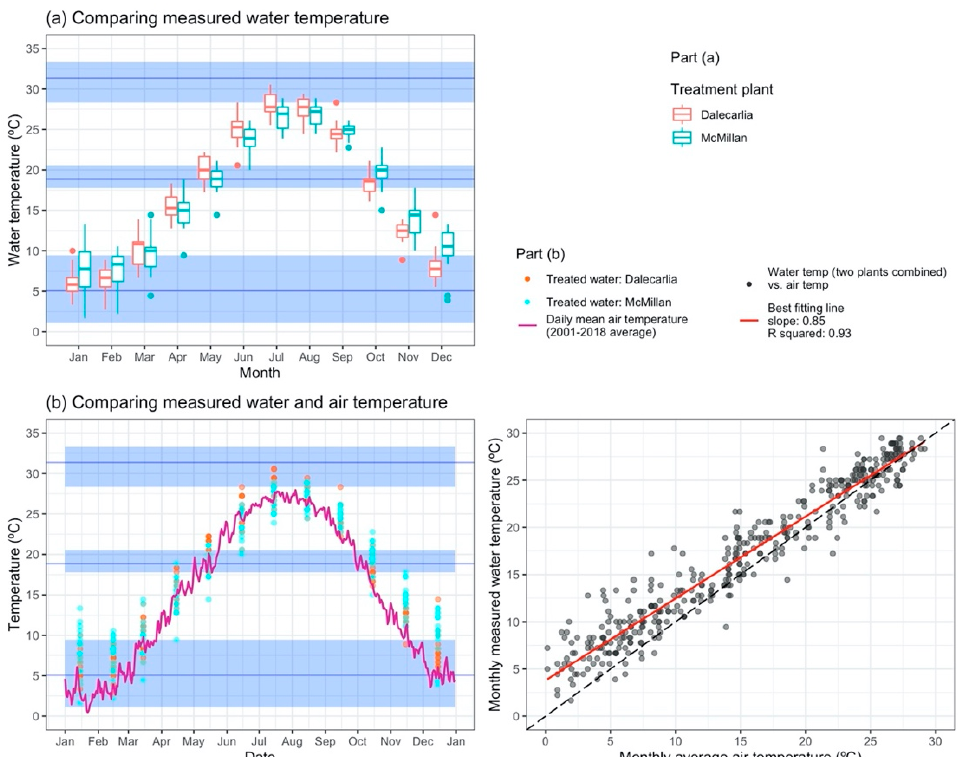
Figure 1. Water temperature measurements and air temperature records from the local weather station (Reagan National Airport) for Washington D.C., with ( a ) boxplots of monthly average temper- ature measurements of treated water (water entering the distribution system) in the two treatment plants of Washington Aqueduct [71] during the period 2001–2018 (each boxplot shows values across the period 2001–2018) and annual water temperature results in the DWDS provided by the DC Water drinking water quality reports [72] for the period 2003–2017; and ( b ) comparison with the air temperature records from the weather station (with the bottom left graph presenting the seasonal variations and the bottom right graph presenting the scatter plots of monthly measured water tem- perature of treated water vs. monthly average air temperature). In part ( a ), the three shaded bars present the reported annual maximum, average, and minimum water temperature in the DWDS from the drinking water quality reports [72] for the period 2003–2017 (with the bounds and bold lines representing the highest, lowest, and mean values reported every year between 2003 and 2017). Monthly temperature measurements for the treated water are presented as points in part ( b ), instead of boxplots as in part ( a